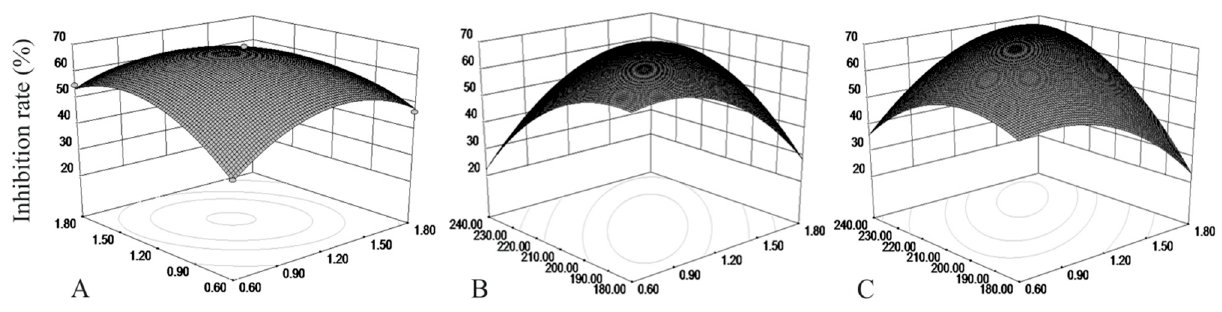
Figure 5. Response surface plots and contour lines of the effects of interaction between the concentra- tions of bran, soybean meal, and rotation speed on inhibition rate. ( A ) Wheat bran/%, ( B ) Soybean meal/%, ( C ) Speed/(r · min − 1 ).